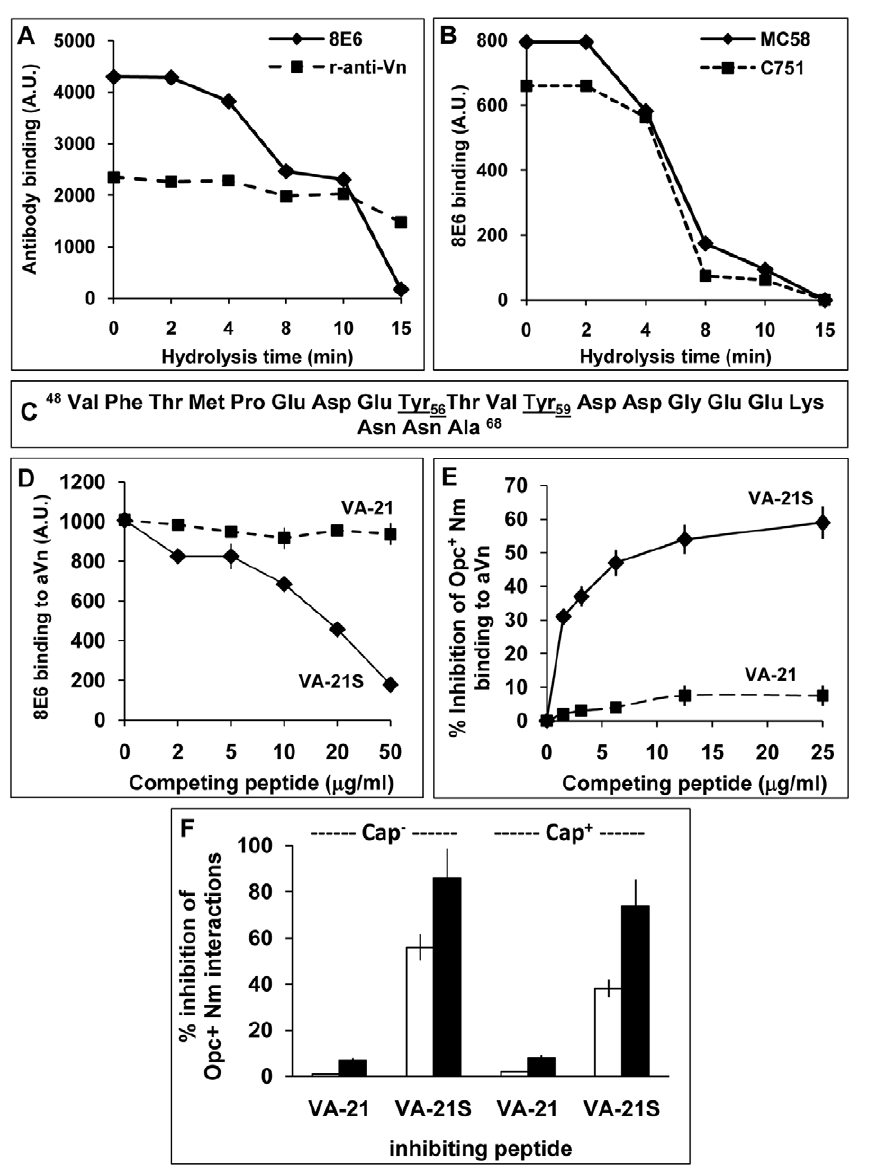
Figure 5. The nature of the vitronectin epitope recognised by N.meningitidis Opc. (A, B) Acid hydrolysis of vitronectin. Immuno-dot blot assays were performed using acid-treated (1 M HCl, 80 u C), immobilised aVn on to nitrocellulose strips. The strips were blocked and overlaid with antibodies or bacteria and analysed for the ability of Vn to retain binding of the mAb 8E6 and polyclonal rabbit anti-Vn antiserum (A) or acapsulate (C751) and capsulate (MC58) Opc + Nm (B). Binding of bacteria and 8E6 declined simultaneously during acid hydrolysis of Vn known to hydrolyse the sulphate groups. (C–E) Studies using synthetic vitronectin peptides. (C) Sequence of synthetic peptides corresponding to the residues 48–68 containing the 8E6 binding site of vitronectin. The peptide VA-21 was synthesised in a non-sulphated form whereas the peptide named VA-21S was sulphated at residues 56 and 59 as in vitronectin. (D) In a competition immuno-dot blot assay, the ability of the mAb 8E6 to bind to immobilised aVn in the absence or presence of the peptides was assessed. 8E6 binding was quantified using AP-conjugated rabbit anti-mouse secondary antibody followed by densitometry. VA-21S but not VA-21 inhibited 8E6 binding to immobilised aVn. (E) In an ELISA, the binding of acapsulate C751 Opc + Nm overlaid on to immobilised aVn was inhibited significantly by the addition of increasing concentration of synthetic peptide VA-21S but to a very low extent with the equivalent unsulphated peptide VA-21. (F) To assess the efficacy of VA-21 and VA-21S to inhibit aVn-mediated adhesion and invasion by acapsulate and capsulate Opc + Nm, viable count experiments were performed. VA-21 or VA-21S peptides (25 m g/ml) were used to pre-coat meningococci (15 min. incubation) which were then added to HBMEC monolayers in infection medium supplemented with aVn (10 m g/ml). VA-21 had no significant effect on adhesion (blank columns) or invasion (filled columns). In contrast, VA-21S reduced cellular adhesion and invasion significantly with a more dramatic effect on invasion levels of both strains.